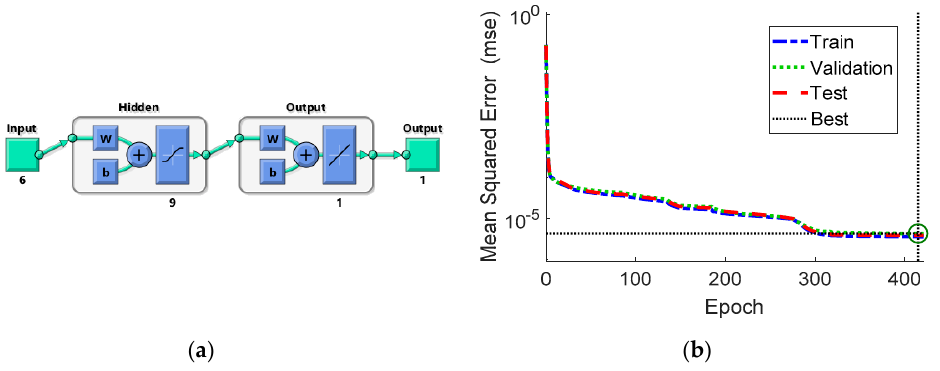
Figure 11b. The best validation performance of 4.2275 × 10 − 6 was achieved at epoch 415.